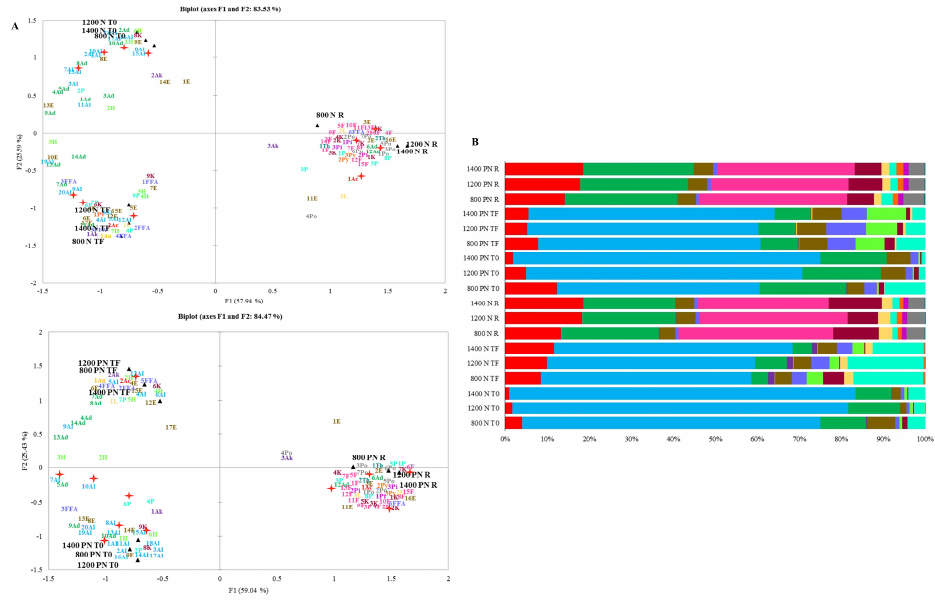
Figure 3. ( A ). Principal component analysis (PCA) of all the volatile compounds detected from each process. The upper graph represents the N process, and the low graph represents the PN process. Represents the volatiles with the highest relative concentrations and correlation with T0, TF, and R. T0: before fermentation, TF: after drying, and R: after roasting. The compound name for each code (1Ac - 2Th) is displayed on Table S1. ( B ). Total relative concentration percentage of the chemical groups detected in the N and PN process and altitude.